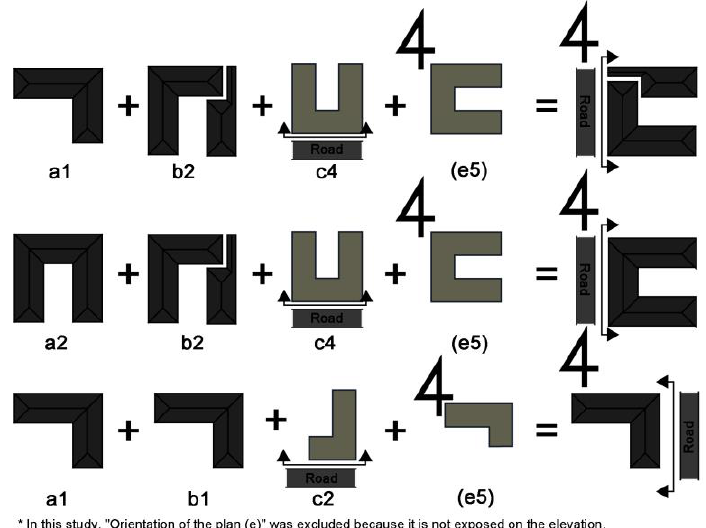
Figure 6. Orientation of the road (C) Reprinted/adapted with permission from Ref. [3]. 2018, Donghwa Shon: Even in the same Hanok, the facade varies depending on the direction facing the road.